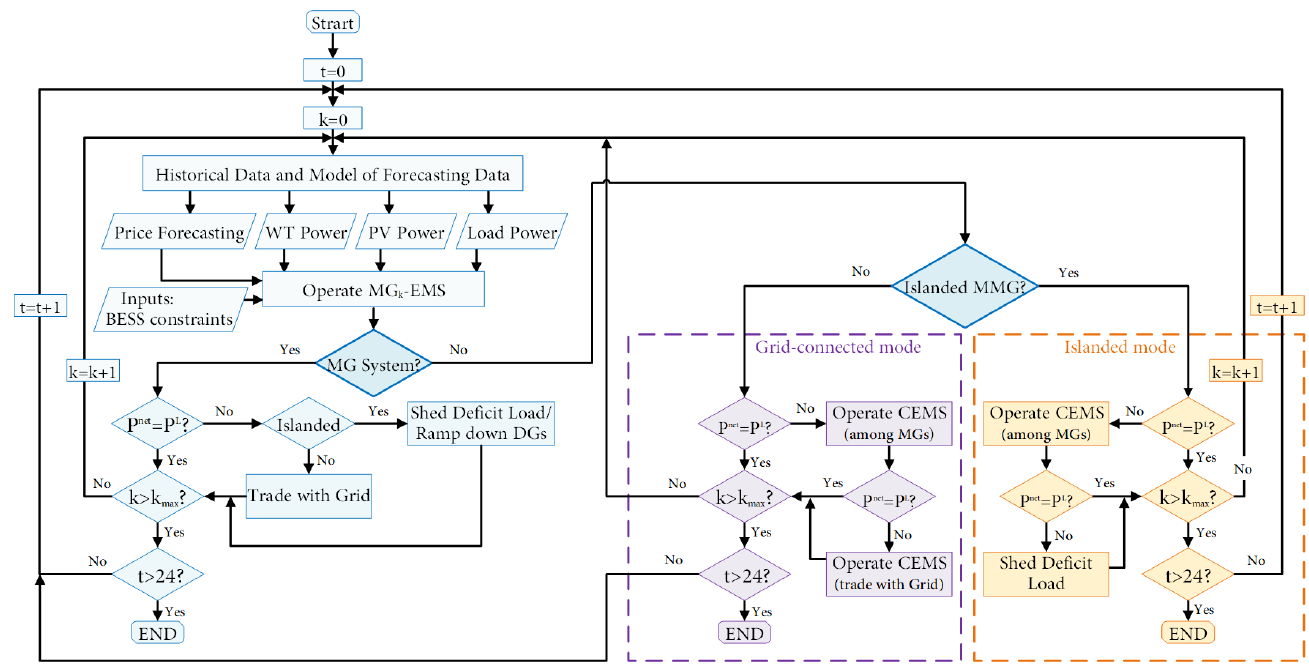
Figure 3. Flowchart of the proposed